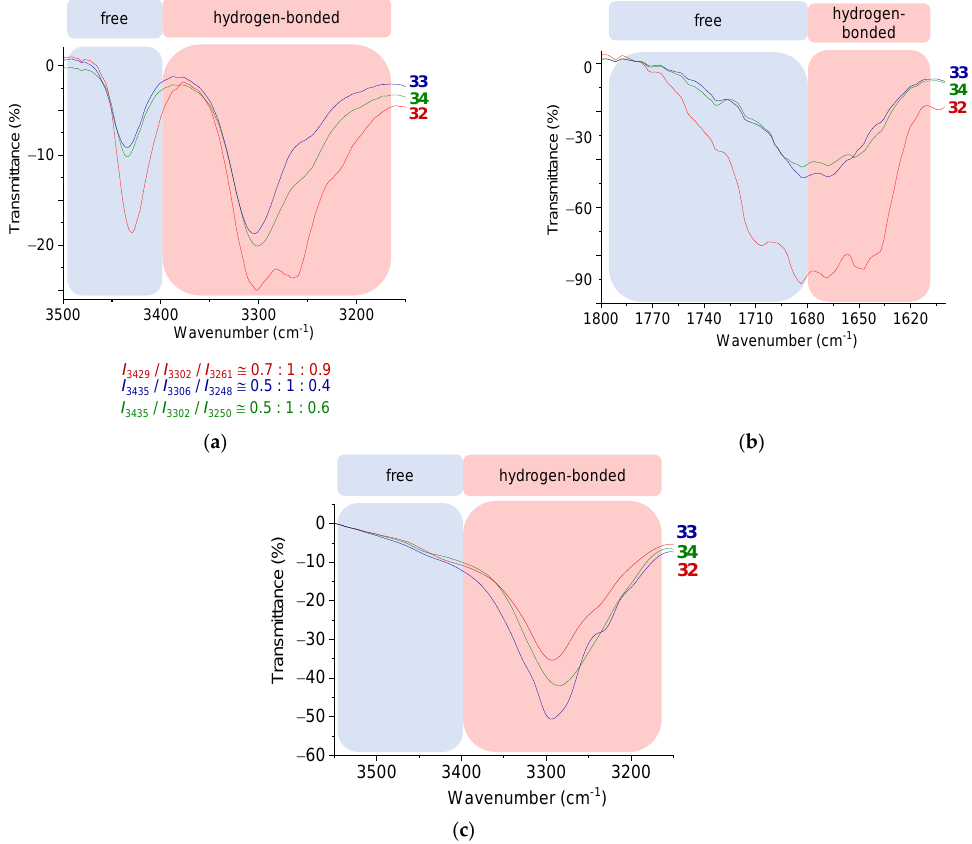
Figure 3. The ( a ) NH and ( b ) CO stretching vibrations in IR spectra of ferrocene-1, 1′ -diamine conjugates with L -Phe ( 32 ), L -Val ( 33 ), and L -Leu ( 34 ) in CH 2 Cl 2 ( c = 5 × 10 −2 M) and ratios of free and associated NH bands; ( c ) the NH stretching vibrations of compounds 32 − 34 (2 mg) in KBr (200 mg).